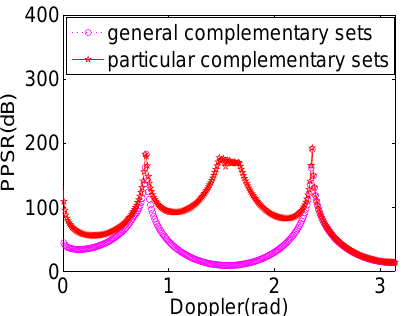
Figure A2. The PPSR of general/particular complementary